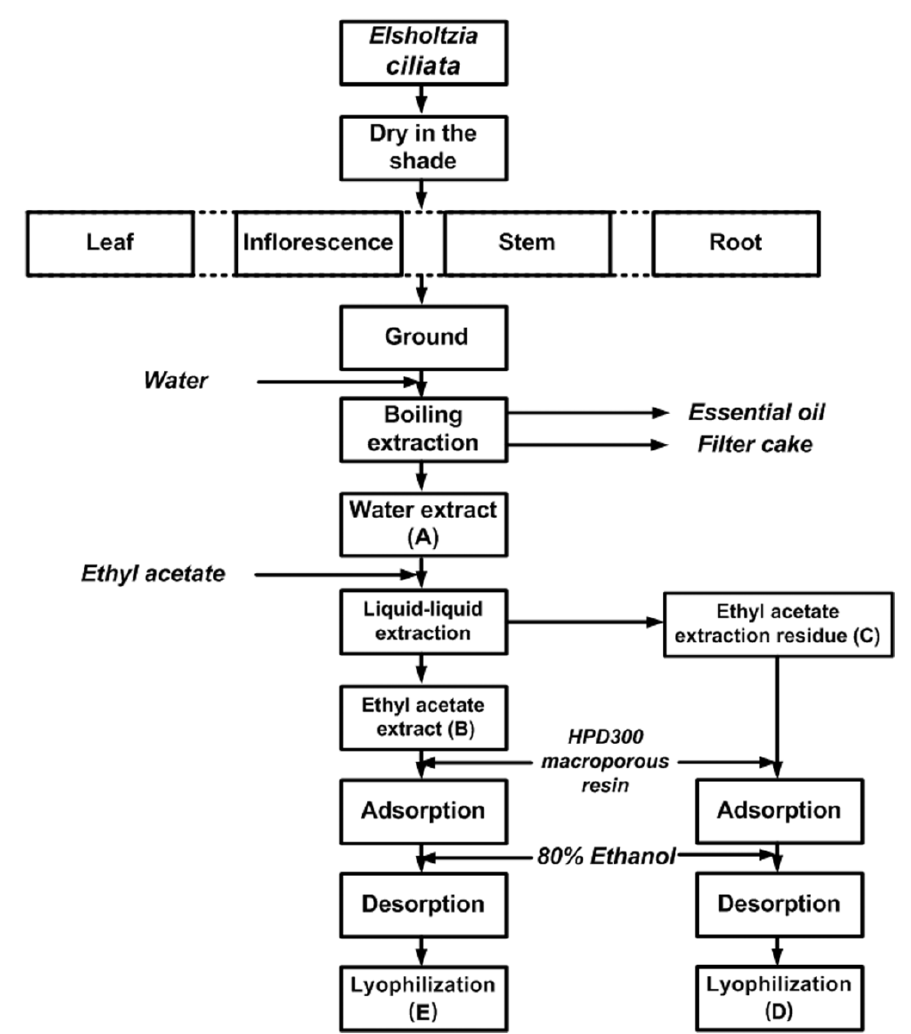
Figure 1. Isolation procedure for extracts of E. ciliata plant parts.